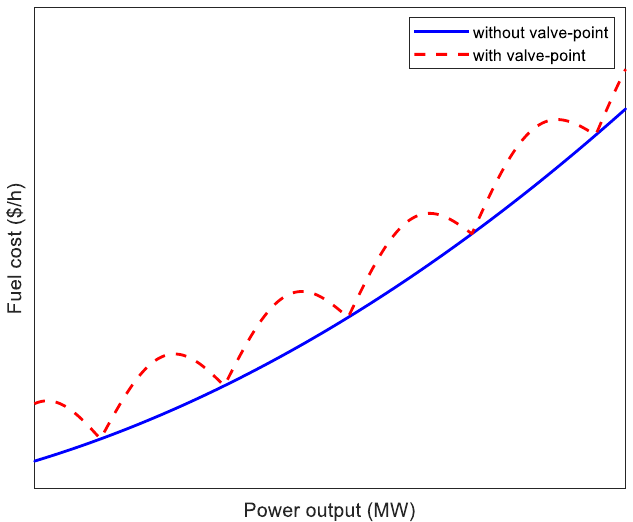
Figure 2. Fuel cost function with valve-point effects.